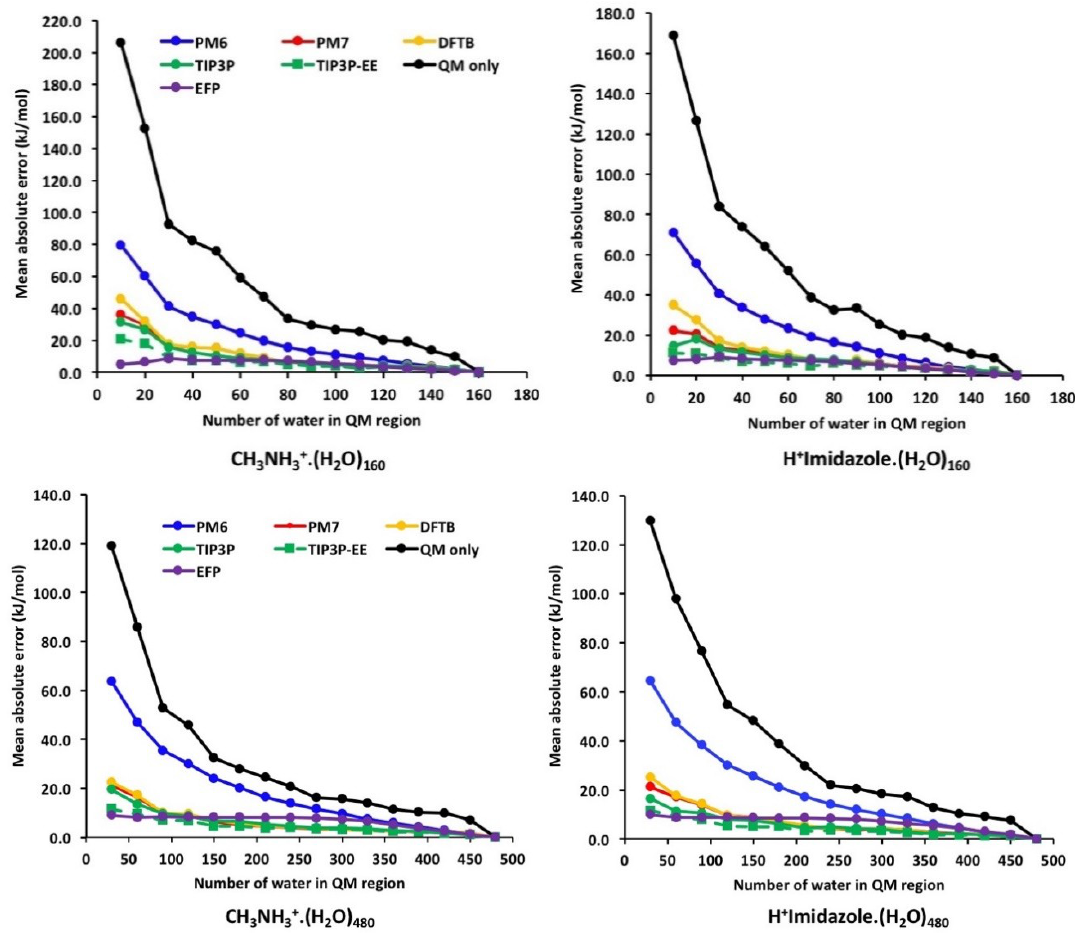
Figure 5. Error convergence profiles for the various QM/MM and QM/QM′ models as a function of QM region size for 160-water cluster ( top ) and 480-water cluster ( bottom ) of cationic acids.